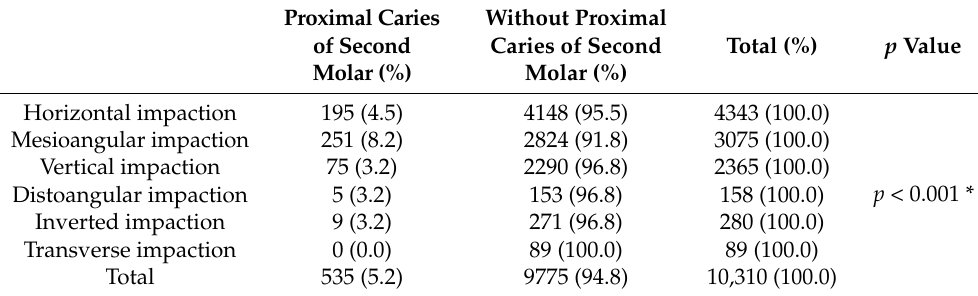
Table 9. Association between impaction angulation and proximal caries of the second molar.